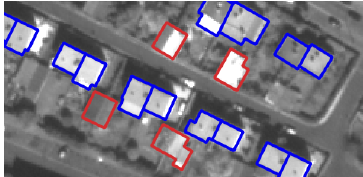
Figure 6. Small independent man-made objects (indicated in red) are not defined as building in the instance segmentation data set and marked as void. Therefore, they are not used for evaluation.